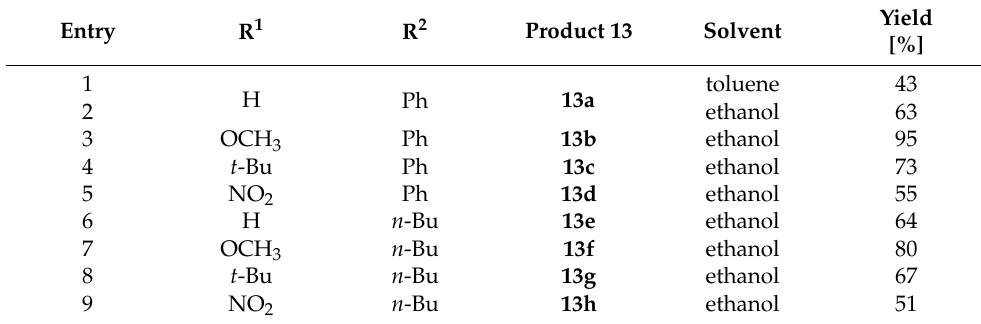
Table 3. The yield of the reaction for the preparation of title derivatives 13a – h .